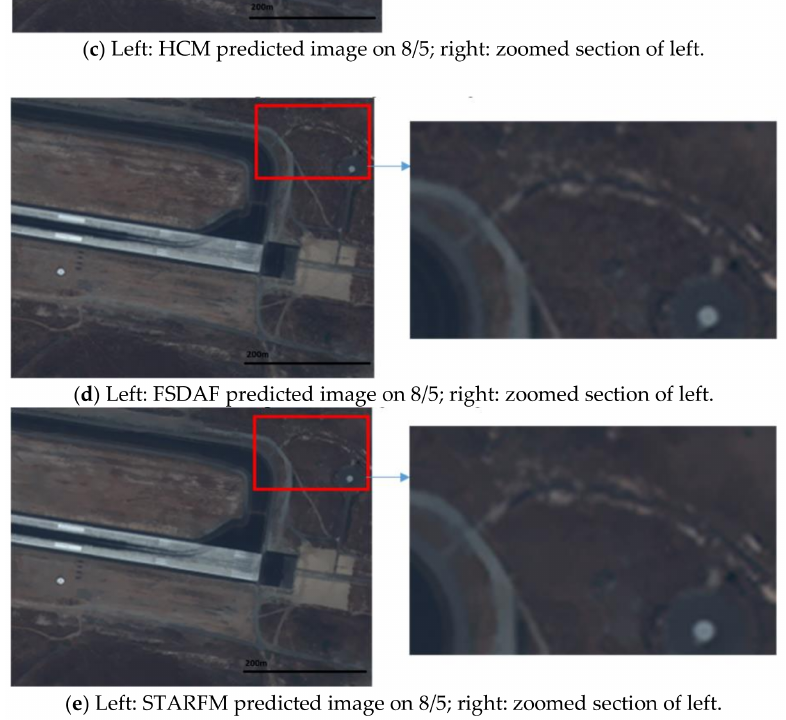
Figure 12. Comparison of different fused images with the ground truth (WV) and the low resolution Planet image at the prediction time. Runway